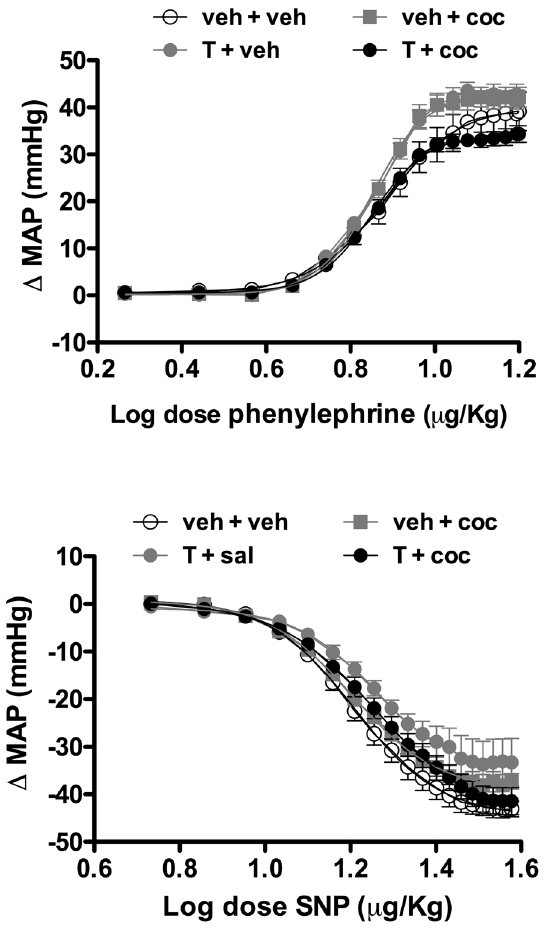
Figure 3. Changes in mean arterial pressure ( D MAP) evoked by increasing concentrations of the selective a 1 -adrenoceptor agonist phenylephrine (top) and the nitric oxide donor sodium nitroprusside (SNP) (bottom) in adolescent animals subjected to treatment for 10 consecutive days with testosterone and cocaine alone and in combination. Circles represent the mean and bars the SEM. veh – vehicle, test - testosterone and coc – cocaine.